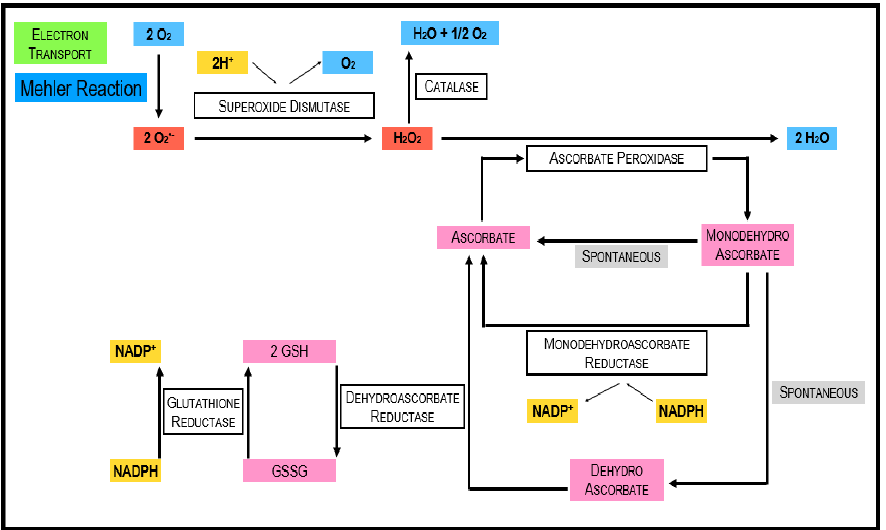
Figure 3. Scavenging of ROS. The figure demonstrates two alternative pathways to scavenge ROS produced by the Mehler Reaction: (i) the SOD-CAT pathway (top left) and (ii) the interplay of antioxidant enzymes in the ascorbate – glutathione cycle.